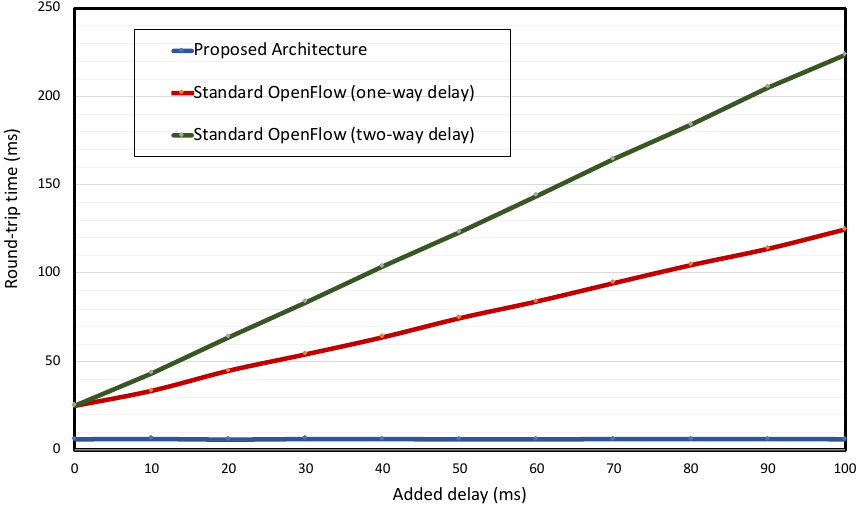
Figure 9. Round-trip times in both architectures and for both additional delay